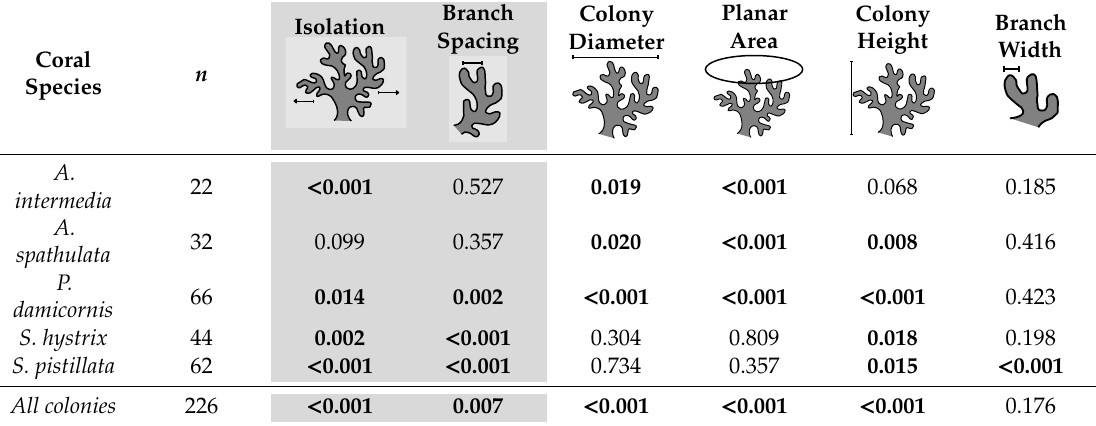
Diversity 2019 , 11 , x 12 of 19 12 of 19 Table 4. Series of linear models illustrating variation in total biomass of damselfish in small branching coral colonies ( Acropora intermedia , Acropora spathulata , Pocillopora damicornis , Seriatopora hystrix , Table 4. Series of linear models illustrating variation in total biomass of damselfish in small branching Table 4. Series of linear models illustrating variation in total biomass of damselfish in small branching Table 4. Series of linear models illustrating variation in total biomass of damselfish in small branching Table 4. Series of linear models illustrating variation in total biomass of damselfish in small branching Table 4. Series of linear models illustrating variation in total biomass of damselfish in small branching Table 4. Series of linear models illustrating variation in total biomass of damselfish in small branching and Stylophora pistillata ), by damselfish ( Chromis viridis , Dascyllus aruanus , Dascyllus reticulatus , coral colonies ( Acropora intermedia , Acropora spathulata , Pocillopora damicornis, Seriatopora hystrix, and coral colonies ( Acropora intermedia , Acropora spathulata , Pocillopora damicornis, Seriatopora hystrix, and coral colonies ( Acropora intermedia , Acropora spathulata , Pocillopora damicornis, Seriatopora hystrix, and coral colonies ( Acropora intermedia , Acropora spathulata , Pocillopora damicornis, Seriatopora hystrix, and coral colonies ( Acropora intermedia , Acropora spathulata , Pocillopora damicornis, Seriatopora hystrix, and coral colonies ( Acropora intermedia , Acropora spathulata , Pocillopora damicornis, Seriatopora hystrix, and Stylophora pistillata ), by damselfish ( Chromis viridis , Dascyllus aruanus , Dascyllus reticulatus , Stylophora pistillata ), by damselfish ( Chromis viridis , Dascyllus aruanus , Dascyllus reticulatus , Stylophora pistillata ), by damselfish ( Chromis viridis , Dascyllus aruanus , Dascyllus reticulatus , Stylophora pistillata ), by damselfish ( Chromis viridis , Dascyllus aruanus , Dascyllus reticulatus , Stylophora pistillata ), by damselfish ( Chromis viridis , Dascyllus aruanus , Dascyllus reticulatus , Pomacentrus amboinensis , and Pomacentrus. moluccensis ) for six fine-scale indicators of colony attributes Stylophora pistillata ), by damselfish ( Chromis viridis , Dascyllus aruanus , Dascyllus reticulatus , Pomacentrus amboinensis , and Pomacentrus. moluccensis) for six fine-scale indicators of colony attributes Pomacentrus amboinensis , and Pomacentrus. moluccensis) for six fine-scale indicators of colony attributes Pomacentrus amboinensis , and Pomacentrus. moluccensis) for six fine-scale indicators of colony attributes Pomacentrus amboinensis , and Pomacentrus. moluccensis) for six fine-scale indicators of colony attributes Pomacentrus amboinensis , and Pomacentrus. moluccensis) for six fine-scale indicators of colony attributes Pomacentrus amboinensis , and Pomacentrus. moluccensis) for six fine-scale indicators of colony attributes (colony level dataset). The first two traits, colony isolation and branch spacing (shaded), had the highest (colony level dataset). The first two traits, colony isolation and branch spacing (shaded), had the (colony level dataset). The first two traits, colony isolation and branch spacing (shaded), had the (colony level dataset). The first two traits, colony isolation and branch spacing (shaded), had the (colony level dataset). The first two traits, colony isolation and branch spacing (shaded), had the (colony level dataset). The first two traits, colony isolation and branch spacing (shaded), had the (colony level dataset). The first two traits, colony isolation and branch spacing (shaded), had the importance for determining colony occupation. Significant p -values are in bold. highest importance for determining colony occupation. Significant p-values are in bold. highest importance for determining colony occupation. Significant p-values are in bold. highest importance for determining colony occupation. Significant p-values are in highest importance for determining colony occupation. Significant p-values are in bold. highest importance for determining colony occupation. Significant p-values are in bold. highest importance for determining colony occupation. Significant p-values are in bold. Colony